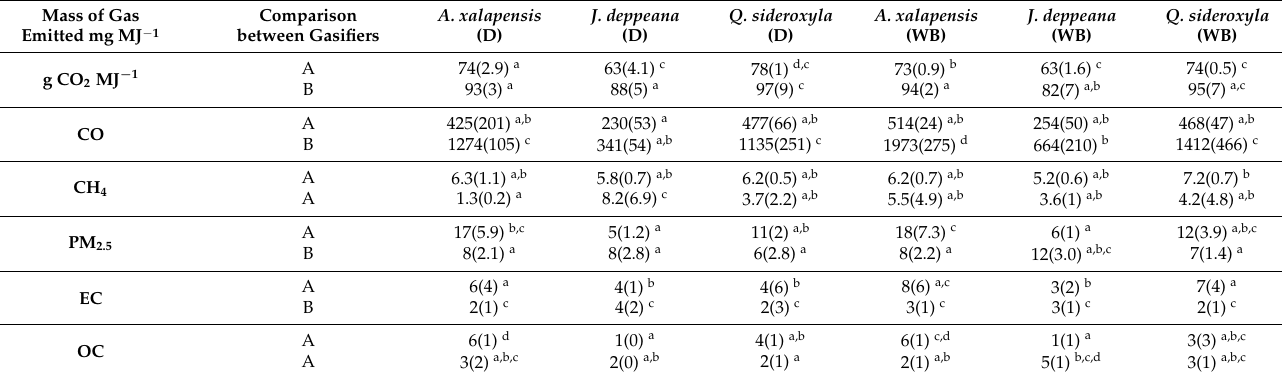
Table 6. Average emission factors per energy source.